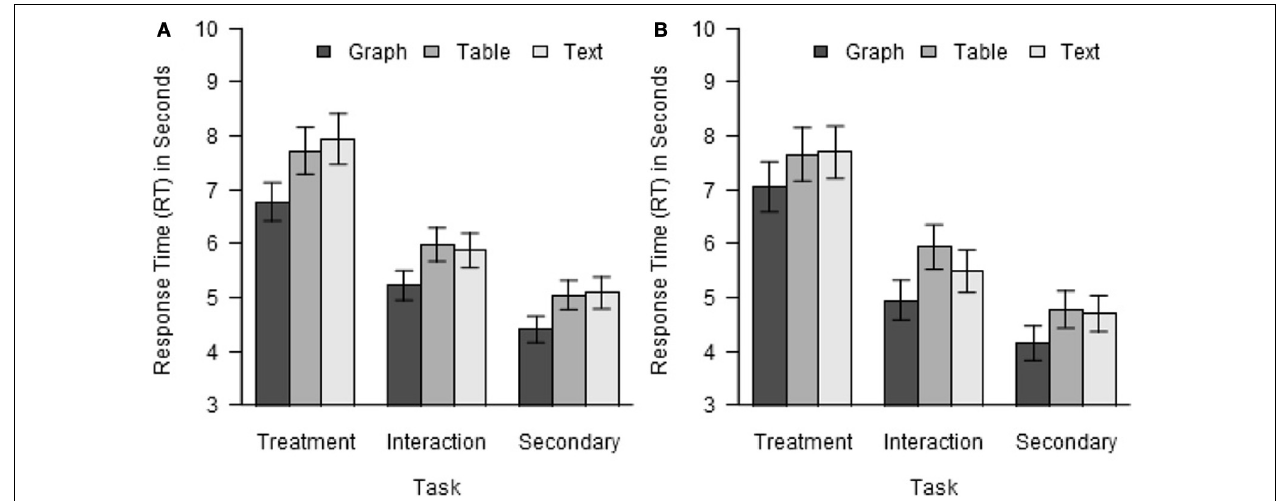
FIGURE 3 | Response time by task and format. (A) Experiment 1. (B) Experiment